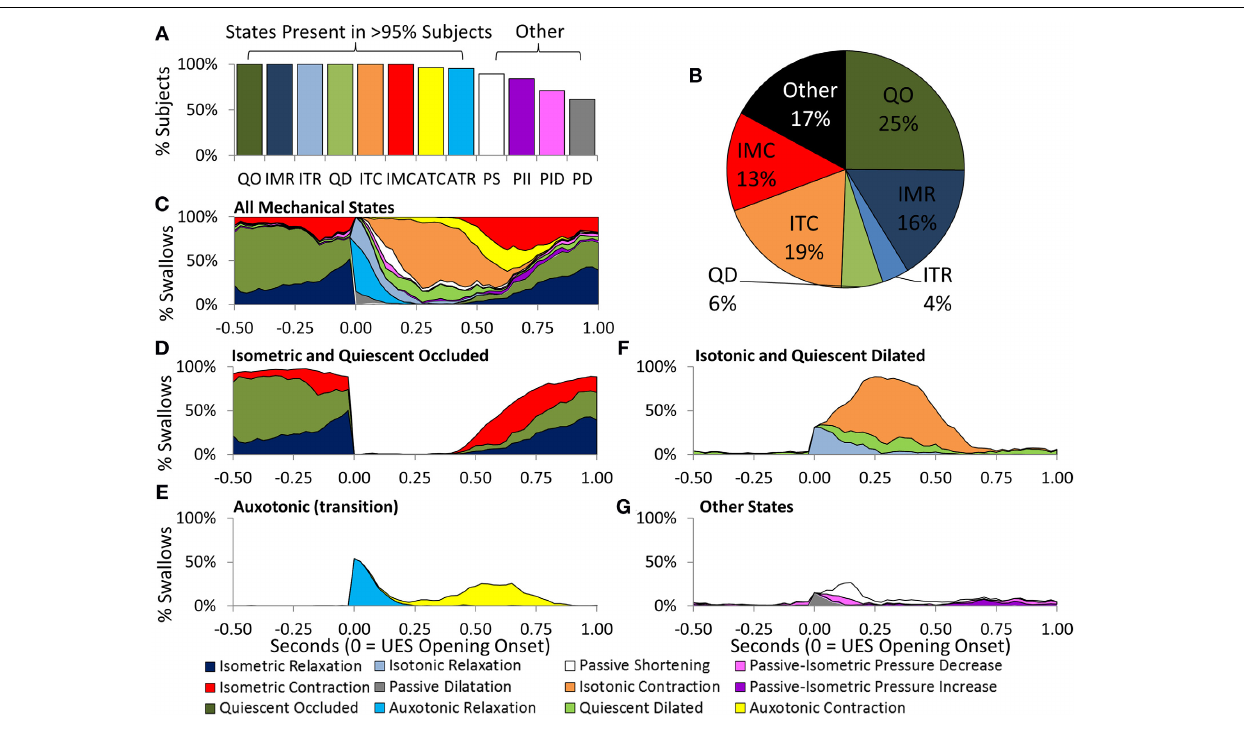
FIGURE 10 | Distribution of Mechanical States predicted across Control Subjects and in relation to time during 5ml swallows. (A) The proportion of subjects demonstrating each of the 12 mechanical states. (B) Pie chart showing the prevelance of the main mechanical states. (C) The timing of occurrence of all mechanical states.